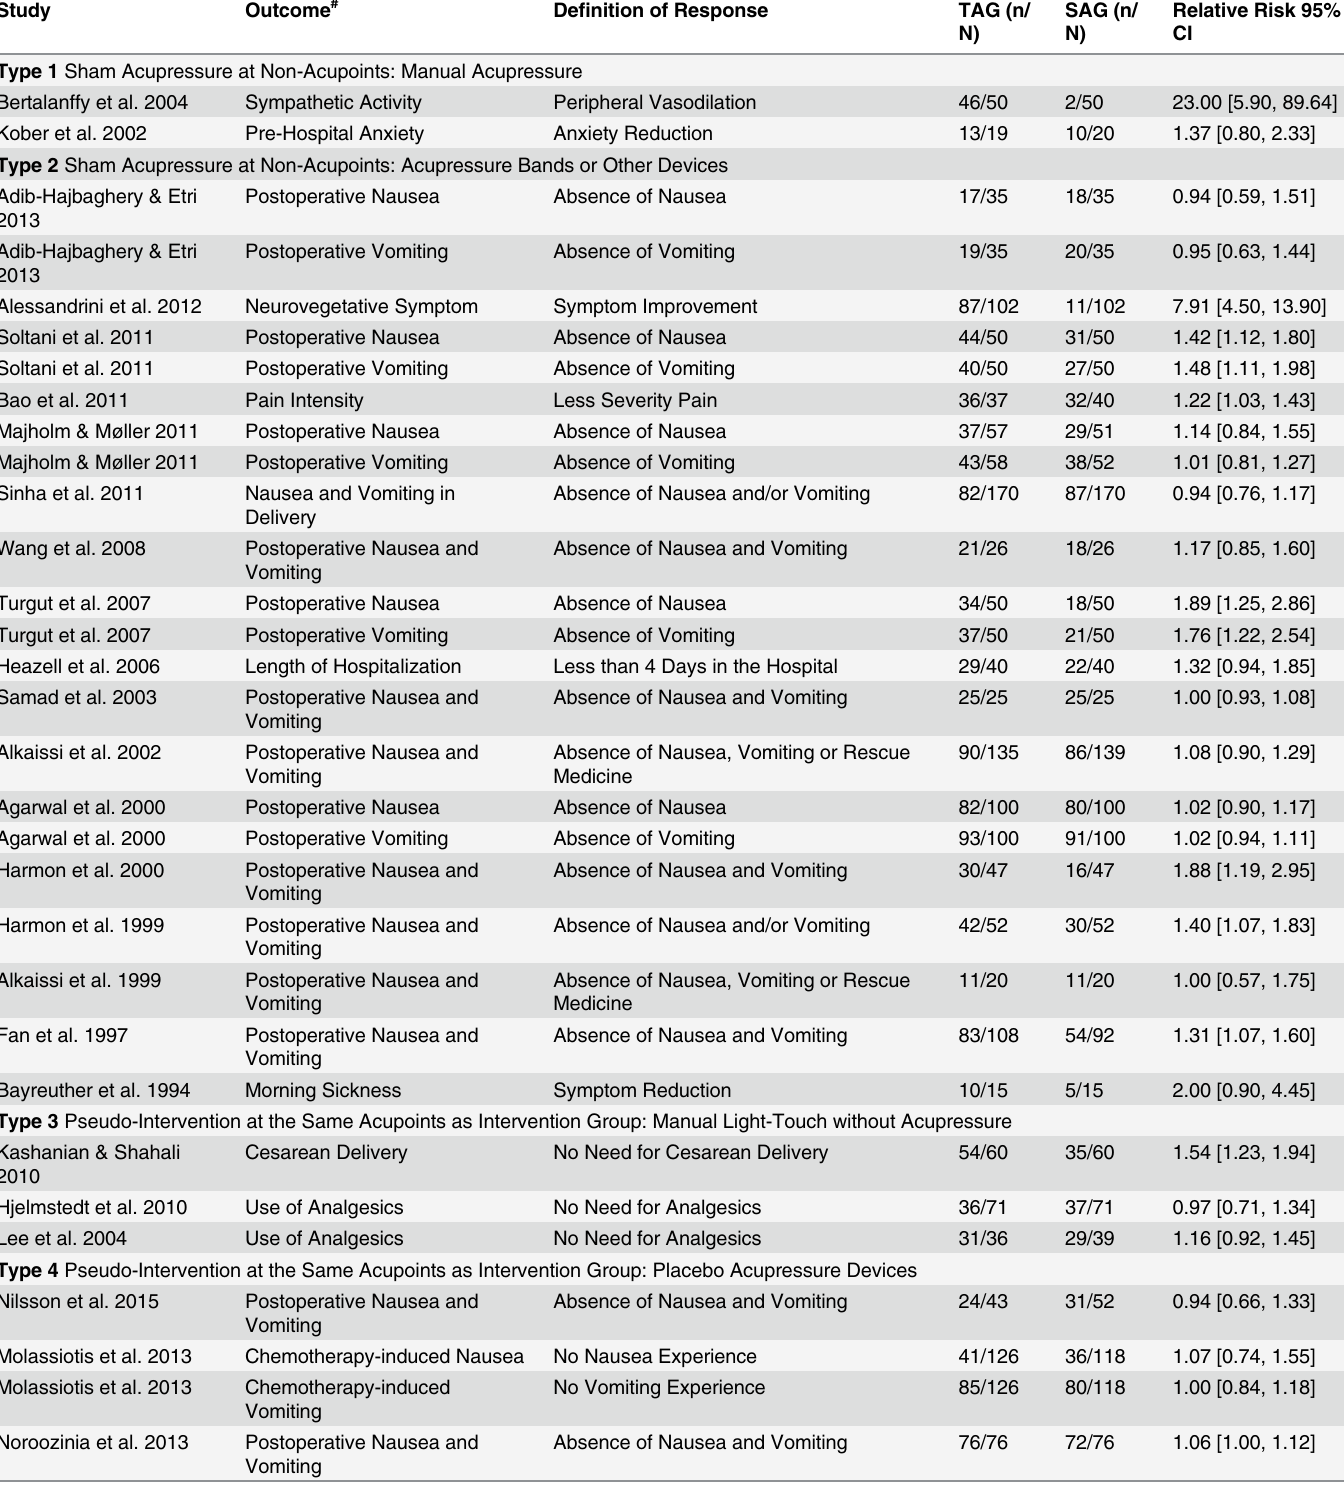
Table 6. Results of Response Rates for Studies Presenting Dichotomous